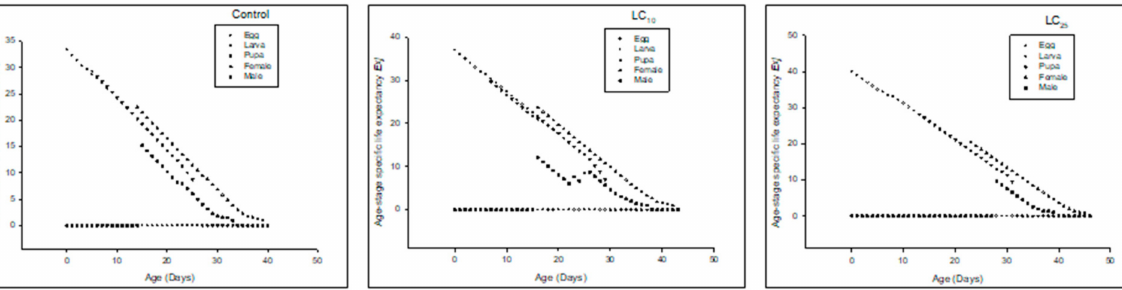
Figure 8. Age stage life expectancy ( e xj ) of the F 2 generation in Spodoptera frugiperda . The v xj of the F 2 generation denoted that the overall reproductive rate was reduced in LC 25 -treated insects, and LC 10 -treated insects had less reproductive rate as compared to the control (Figure 9).